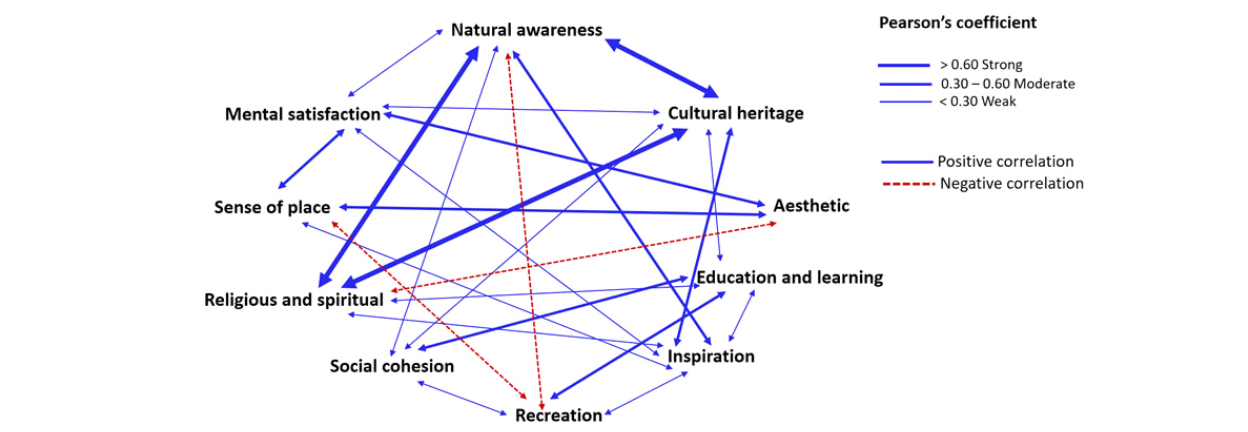
Fig. 5 . Bivariate correlations between stated importance of cultural ecosystem services across participants, p < 0.01 (2-sided). Strength of the arrows indicate the strength of Pearson’s r coe ffi cients.